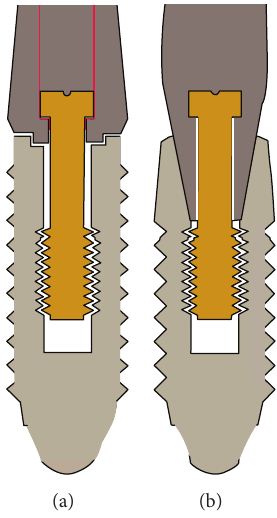
Figure 1: The butt joint connection (a) and the internal Morse connection